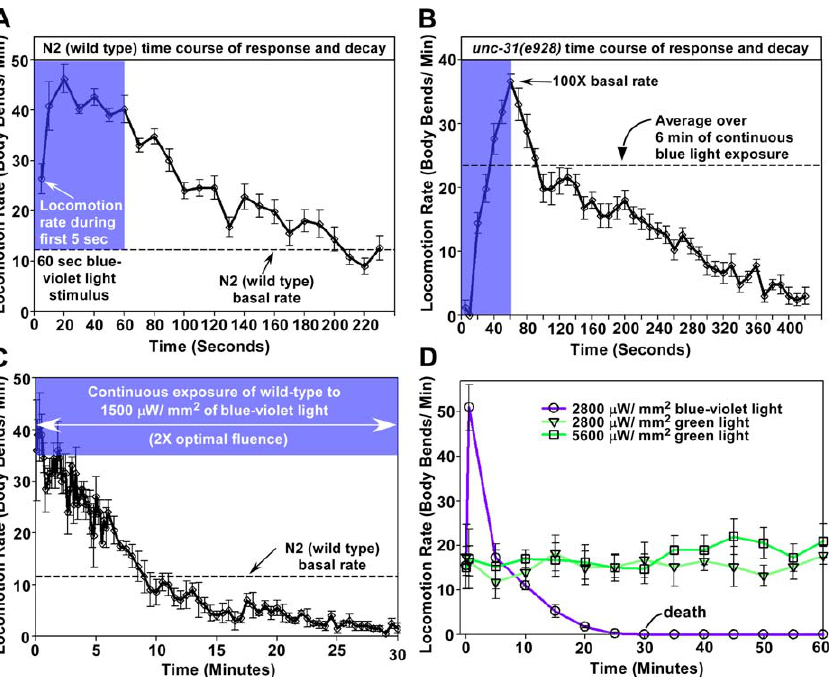
Figure 4. Time Course of Light-Induced Movement and Death (A) and (B) Mean locomotion rates of wild type and the unc-31 null mutant during a time course exposure to blue-violet light of optimal power (730 l W/ mm 2 for wild type and 1460 l W/mm 2 for the unc-31 null). Blue-violet region indicates the time of illumination; later times show the response’s decay after switching to low power white light. Error bars are the standard errors of ten animals. (C) and (D) After mounting a robust escape response, wild-type animals gradually slow down and die during continuous blue-violet illumination. Note that green light of twice this power does not cause death or even slow locomotion, even though it heats worms three times as much as the power of blue-violet light used in (C) (see Figure 3 for temperature measurements). Error bars are the standard errors of four